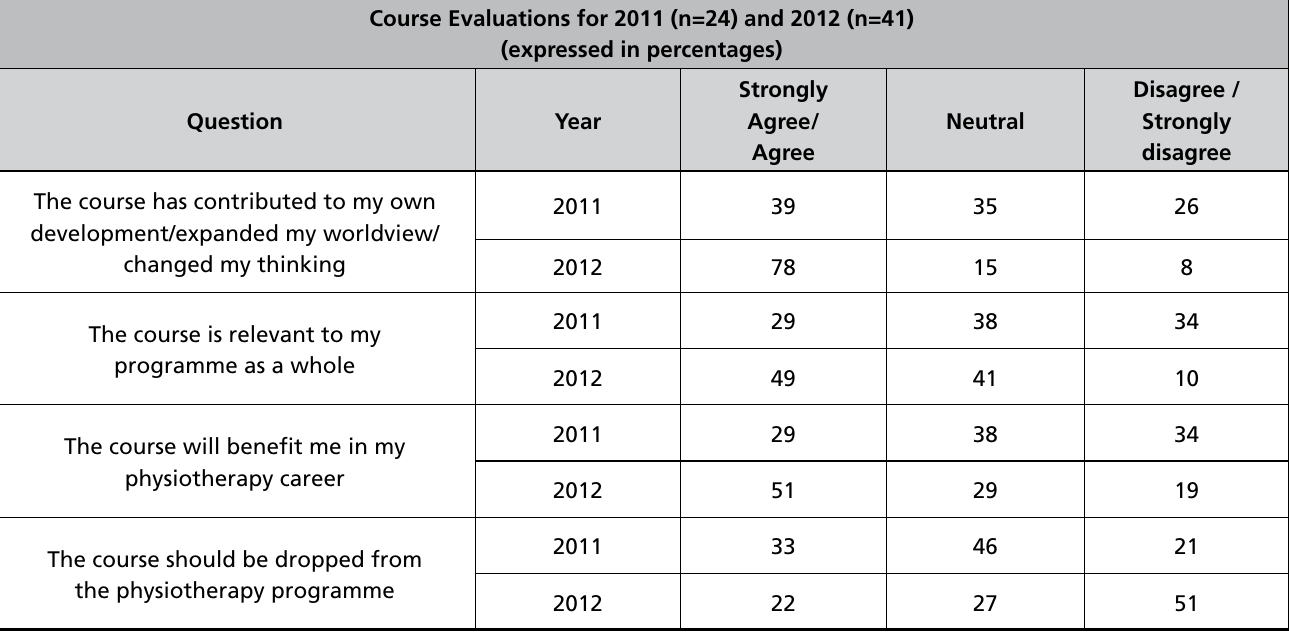
table 1: course evaluations for 2011 and 2012 course evaluations for 2011 (n=24) and 2012